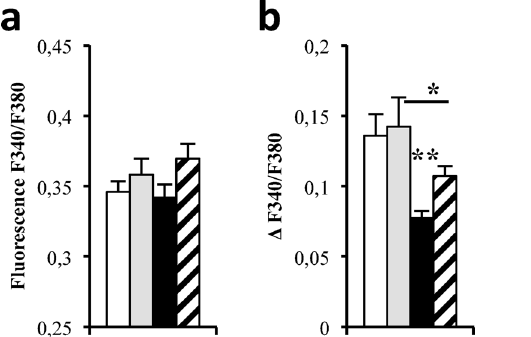
Fig 2. Translocon inhibition partially prevents palmitate-induced reticular calcium depletion. Quantification of fluorescence ratio (F340/F380) of resting calcium ( a ) and of reticular calcium release induced by 1 μ M thapsigargin ( b ) in 4 different human islets preparations (11 cells per preparation) under 48h BSA (white bar) + anisomycin (grey bars and palmitate (black bar) conditions + anisomycin (hatched bars). * p < 0.05, ** p <